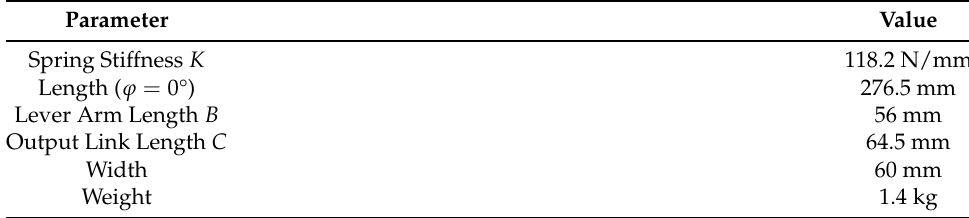
Figure 2. ( a ) Front view of the SMARCOS (at ϕ = α = 0 ◦ ). In this position, the hard stop 1 pushes on the motor cage to prevent the lever arm to run into the spindle and the ball-screw nut to run into the motor-spindle combination. ( b ) Top view of the SMARCOS (at ϕ = α = 0 ◦ ). ( c ) Front view of the SMARCOS. Without electronics and cover, the actuator weighs 1.4 kg. Table 1. Main design parameters of the